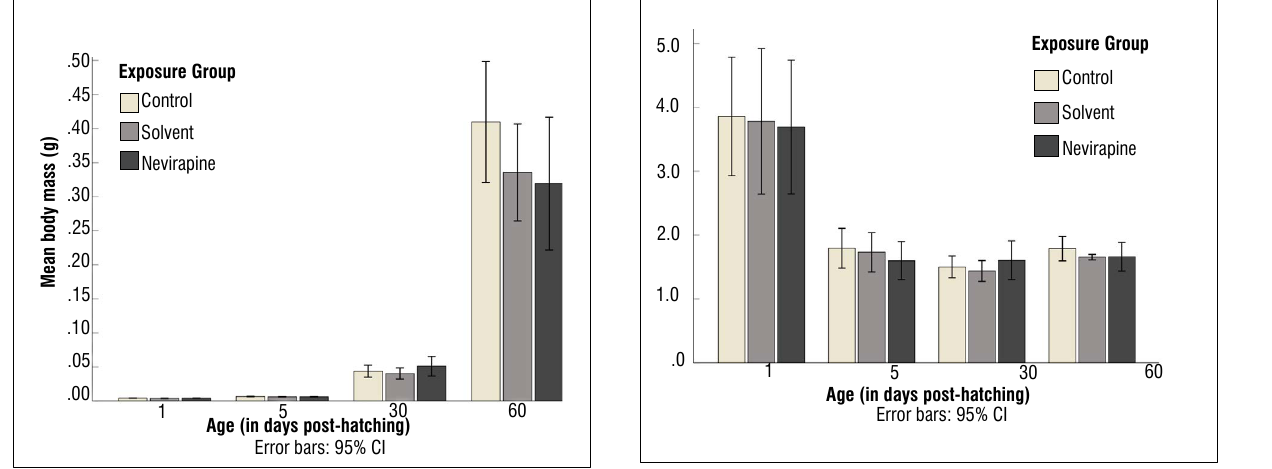
Figure 3: Mean body mass of fish in the three exposure groups on Days 1, 5, 30 and 60 post-hatching.